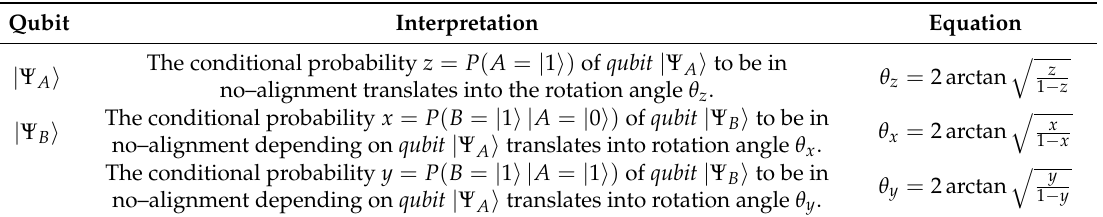
Table 1. Qubit angles of rotation